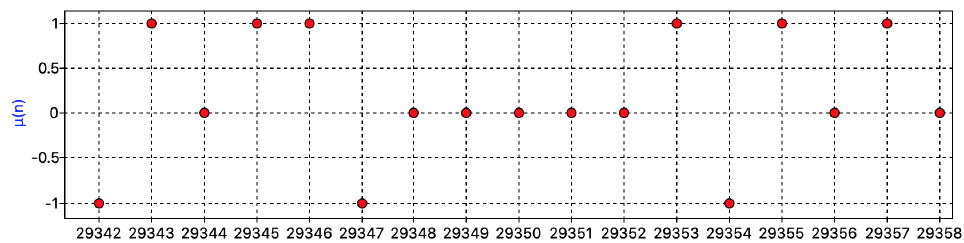
Figure 8. The simulation for µ ( n ) and 1 ≤ n ≤ 29,360, zooming in on the value n =